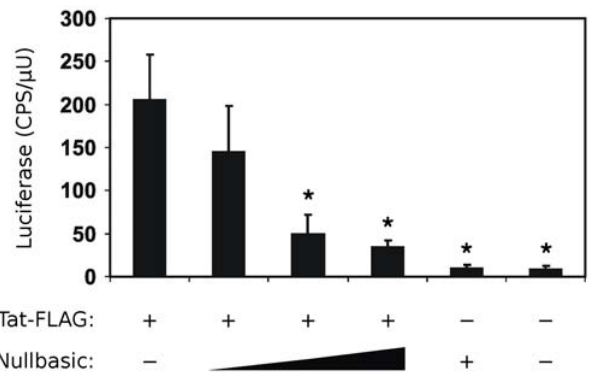
Figure 2. Nullbasic inhibits Tat-mediated transactivation. Increasing amounts (200 ng, 2 m g and 4 m g) or Nullbasic expression vector were titrated into cells co-transfected with constant amounts of Tat-FLAG plasmid, a luciferase reporter of Tat transactivation (HIV-1 LTR promoter) and a constitutive b -galactosidase expression plasmid (CMV promoter). Luciferase values (CPS, counts per second) were normalized to b -galactosidase activity ( m U). Asterisks indicate significant decreases ( p , 0.05) in transactivation compared to uninhibited Tat-FLAG (first column). Columns represent the means and standard deviations of three independent